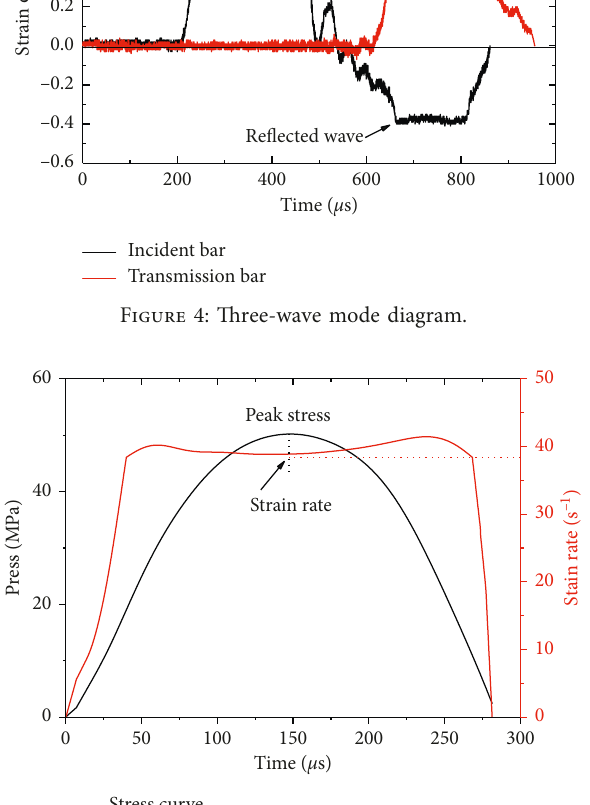
Figure 5: Schematic of the strain rate representative value determination.